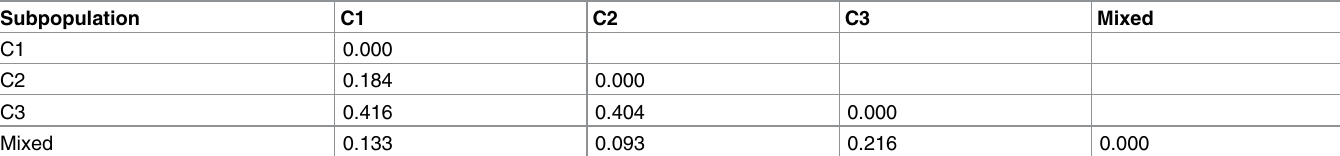
Table 5. Pairwise estimates of PhiPT values among the subpopulations as identified in STRUCTURE